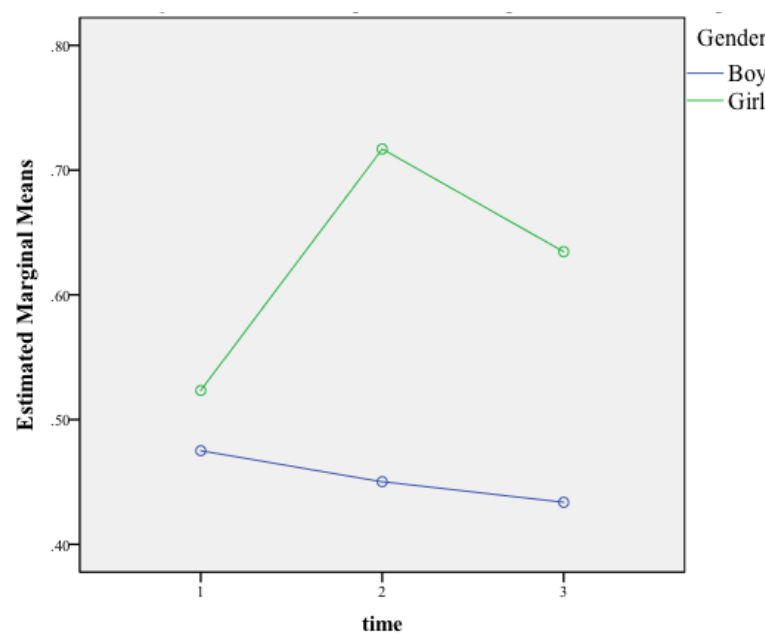
Figure 2 . Percent attempted use of manipulatives across 3 timepoints Change within sessions. To examine the impact of peers on strategy use we observed strategy use change within a single session with the children taking turns solving seven problems. We used repeated measure analyses of variance with attempted and correct strategy use as the dependent variable and group gender as the independent variable. Although the main focus was on attempted use of different strategies we also wanted to examine how group interaction may affect the accuracy of the